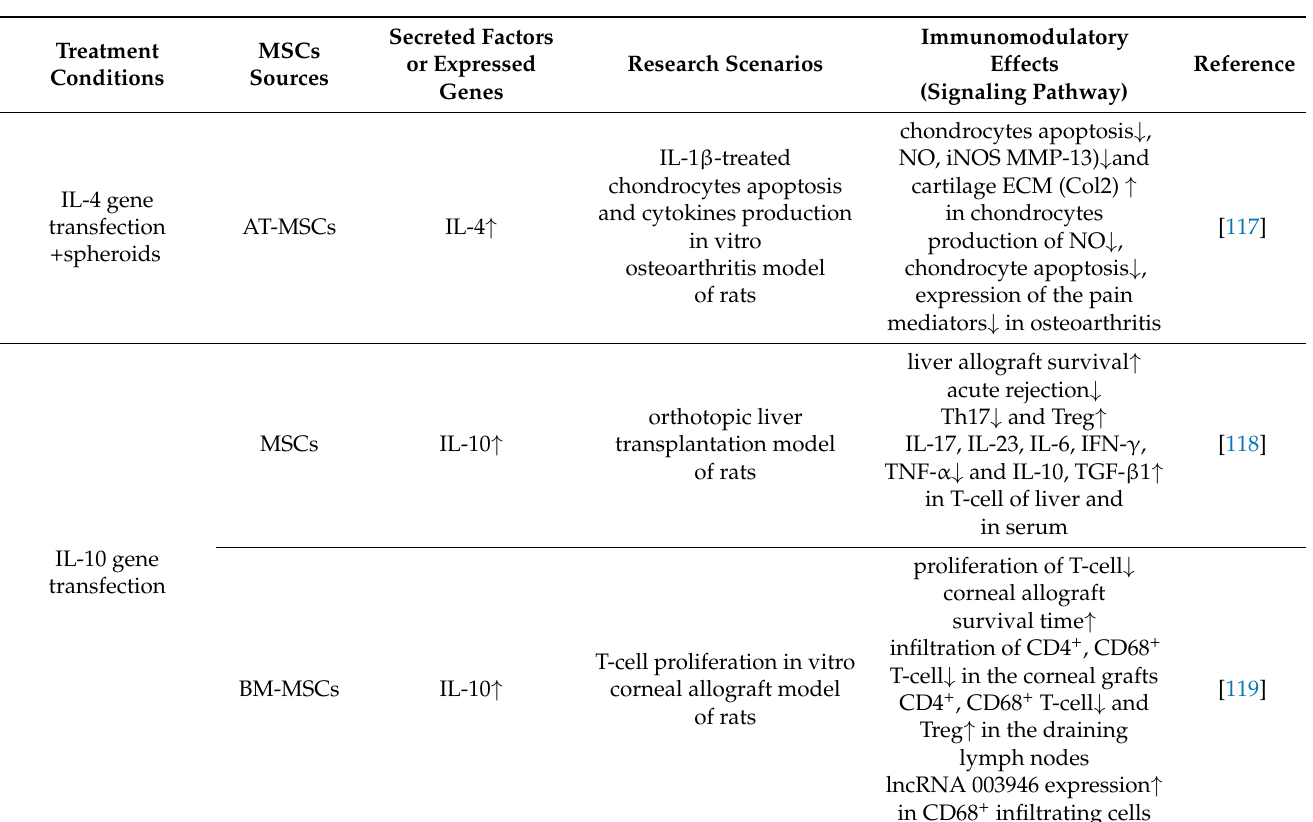
Table 4. Engineering pretreatment of